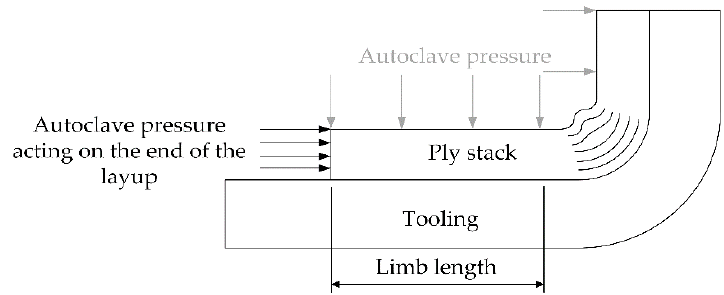
Figure 10. Fiber waviness due to autoclave pressure acting on the end of the layup.